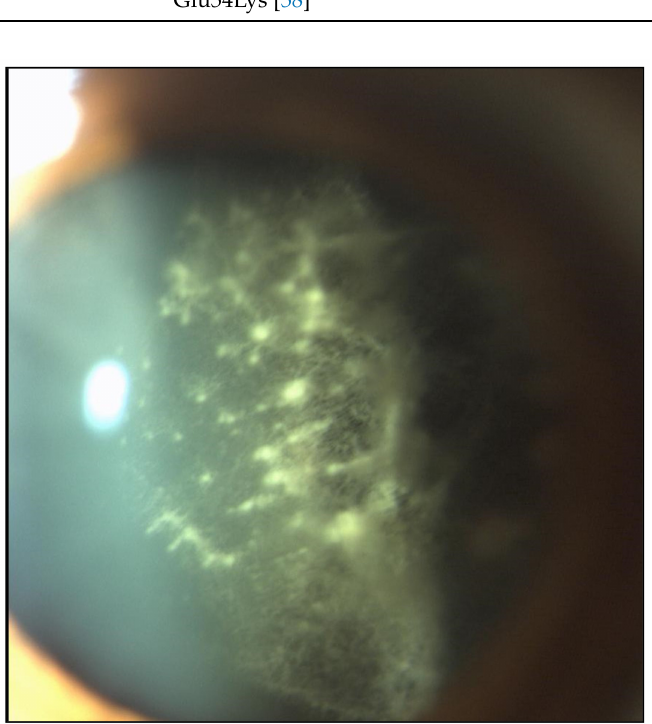
Figure 5. Classical appearance of retrolental vitreous amyloid opacities in ocular TTR amyloidosis examined by slit-lamp examination: multiple sheet-like, cobweb-like and glass wool-like fibrils are present (magnification 16 ×